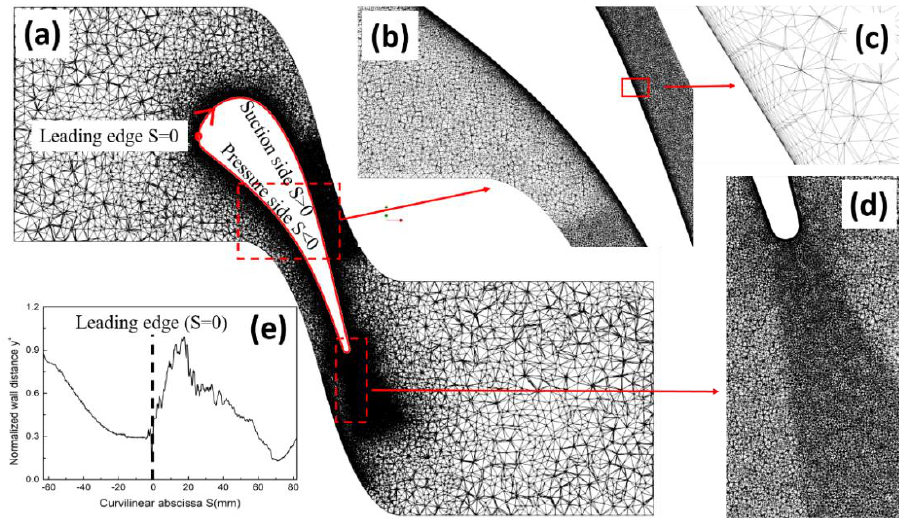
Figure 2. Sketch of coarse mesh ( a ), details of the refined mesh in simulation ( b ), ( c ), ( d ) and the distribution of the normalized wall distance y + (estimation based on result of MUR129_ SAS ) ( e ).